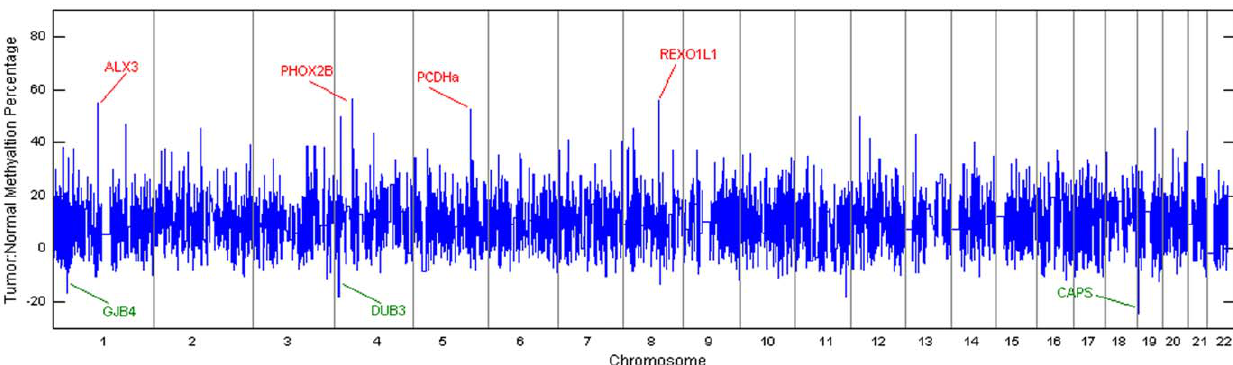
Figure 3. MOMA methylation in ovarian cancer tumors. The tumor:normal ratio percentage for MOMA methylation per gene from 42 ovarian cancer tumor samples and 7 tissue normal samples is outlined per chromosome. For each sample the mean methylation value is calculated from the maximum MOMA value per probe that incorporates the gene promoter region. MOMA methylation data covered 11,978 gene promoter regions. Prominent hypermethylation (red) and hypomethylation (green) genes are labeled and provided in Table S2.